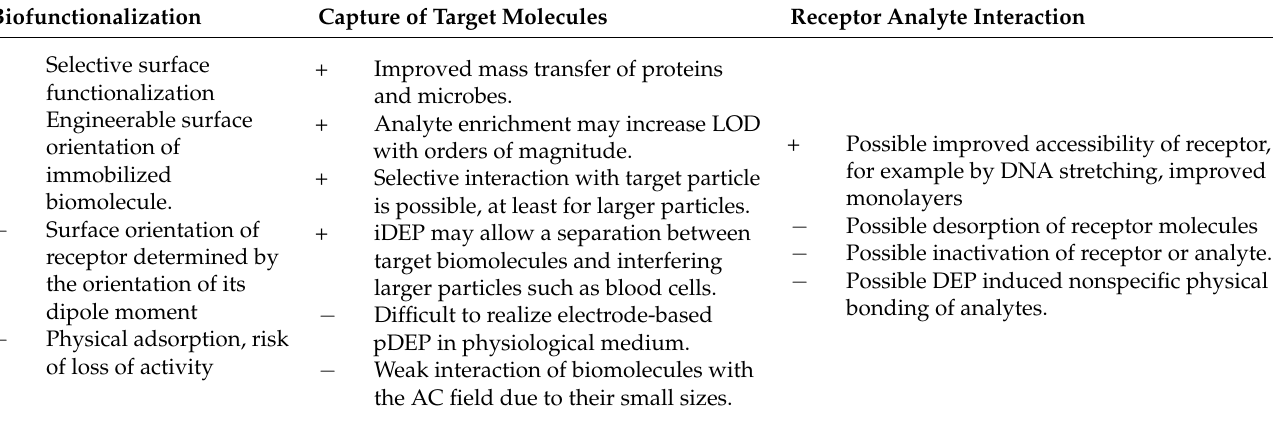
Table 2. Opportunities and challenges of DEP assisted